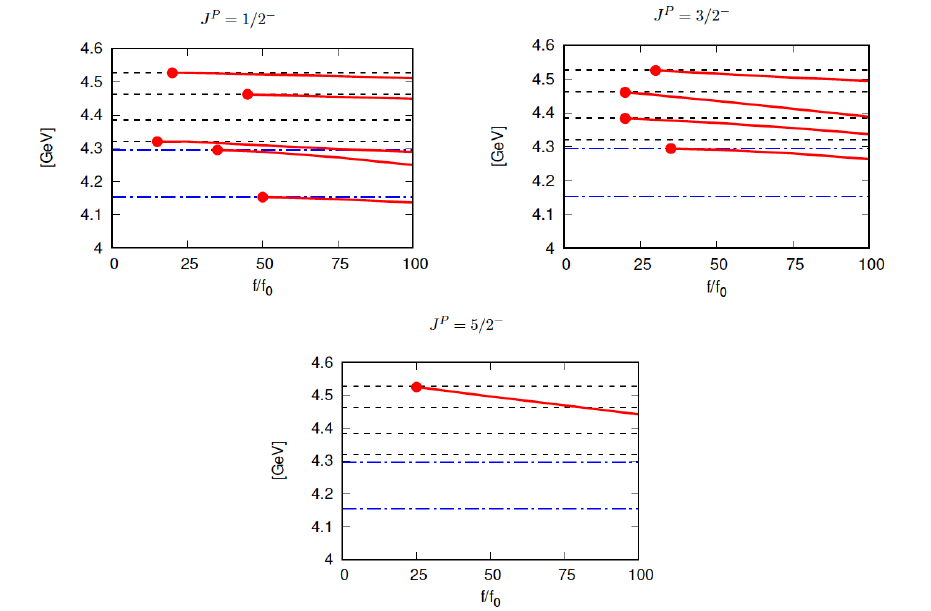
Figure 5. Bound and resonant state energies of the hidden-charm molecules (solid lines) with vari- ous coupling constants f. Dot-dashed lines are the ¯ D Λ c and ¯ D ∗ Λ c thresholds. Dashed lines are the ¯ D Σ ¯ D Σ ∗ , ¯ D ∗ Σ c and ¯ D ∗ Σ ∗ thresholds. The lowest threshold, ¯ D Λ c , is at 4150 MeV and the state whose c , c c energy is lower than the threshold is a bound state (APS copyright